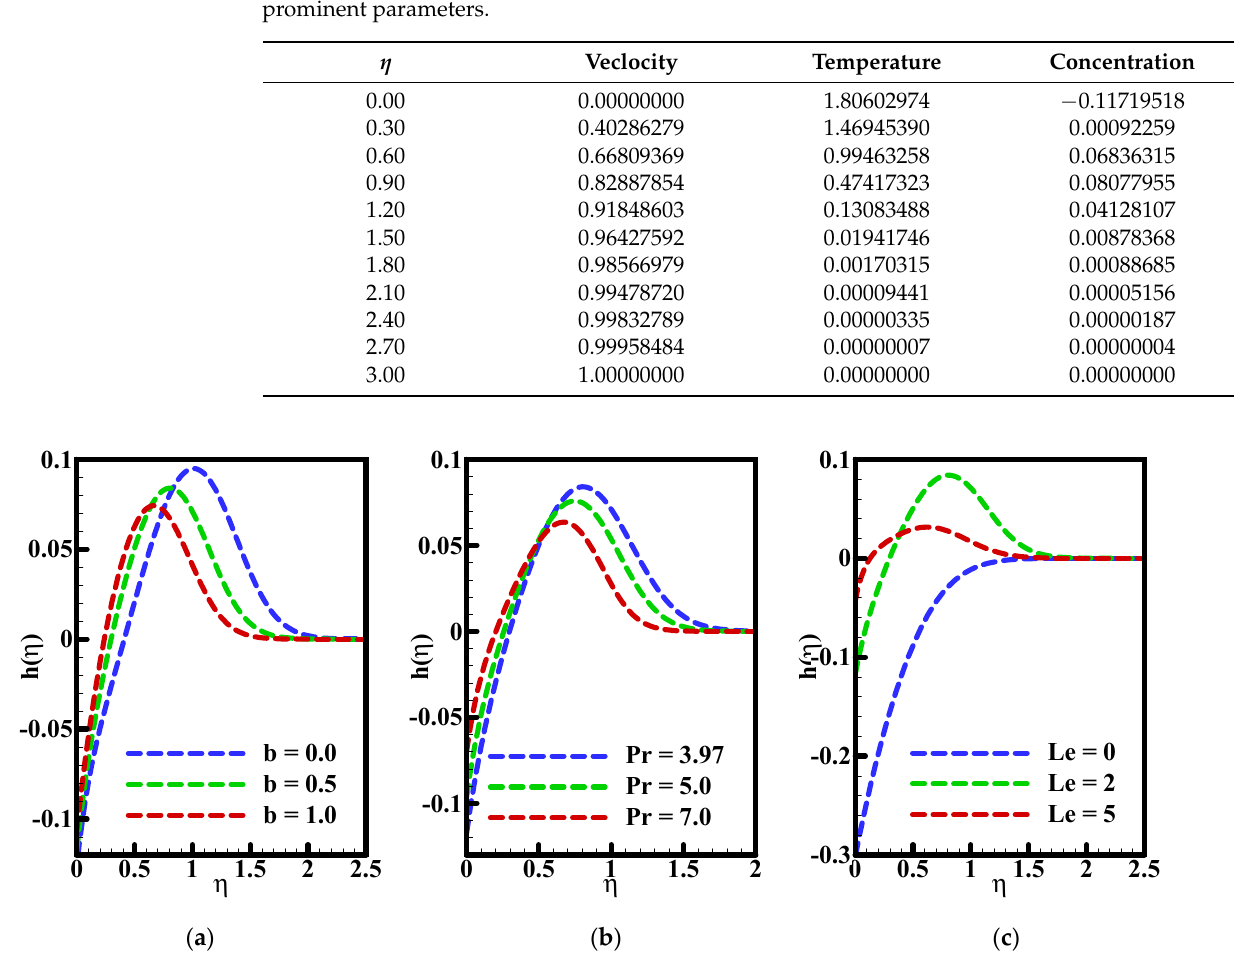
Figure 4. Effect of the parameters ( a ) 𝑏, ( b ) Prandtl number ( 𝑃𝑟 ), and ( c ) Lewin number ( 𝐿𝑒 ) on the dimensionless concentration profile and numerous choices of emerging parameters.